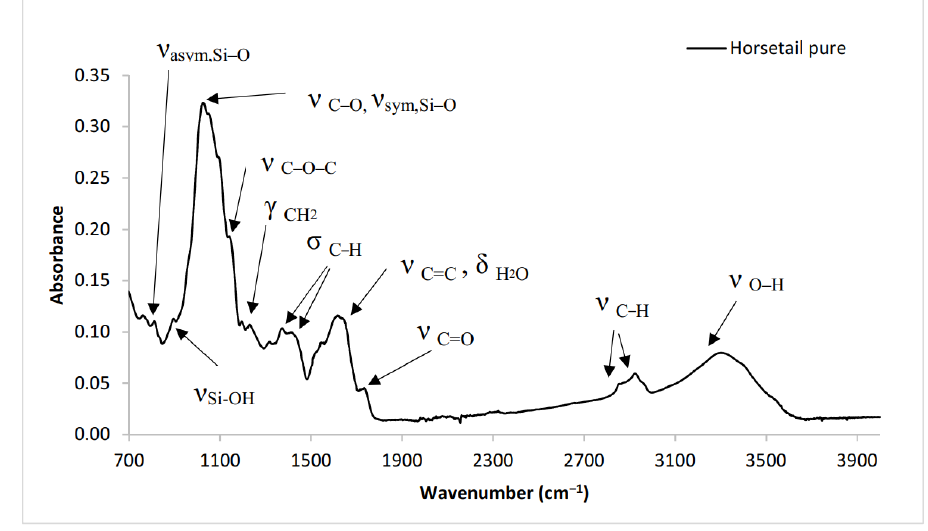
Figure 3. The FTIR spectrum of horsetail.